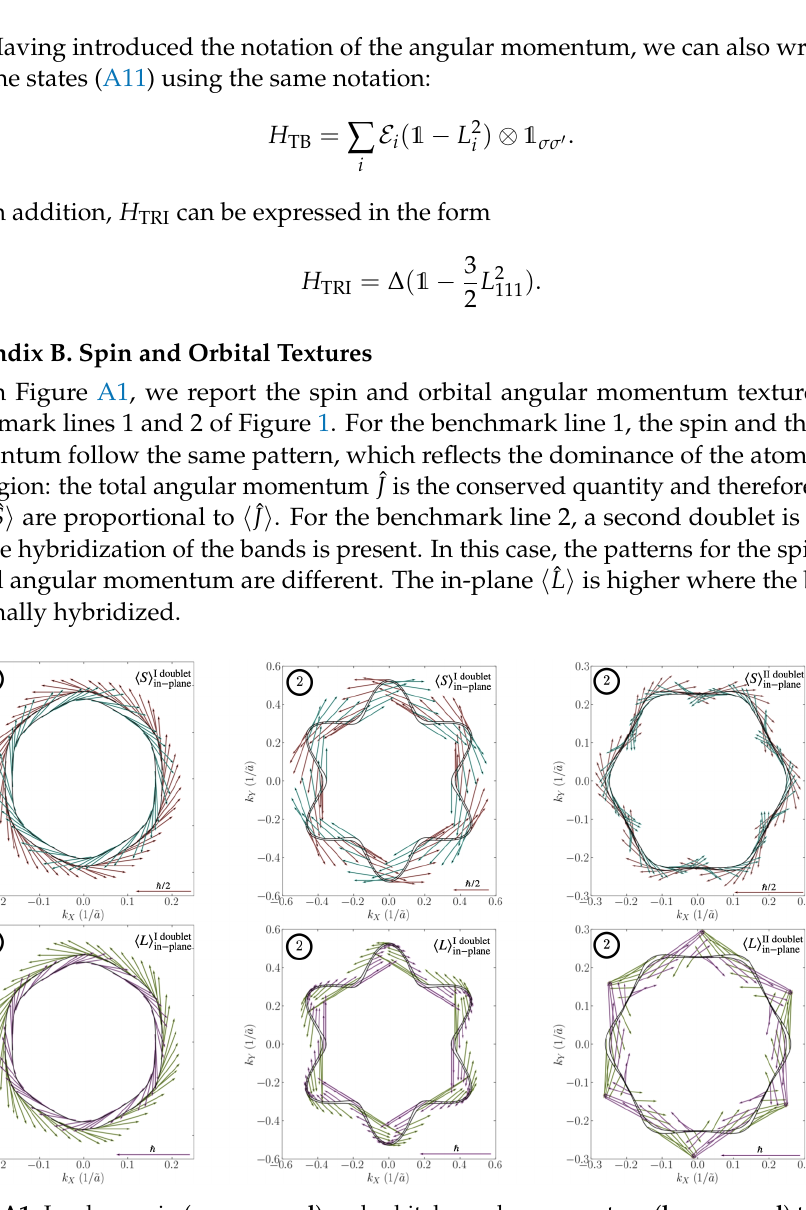
(cid:113) (cid:104) O (cid:105) 2 + (cid:104) O (cid:105) 2 110 112